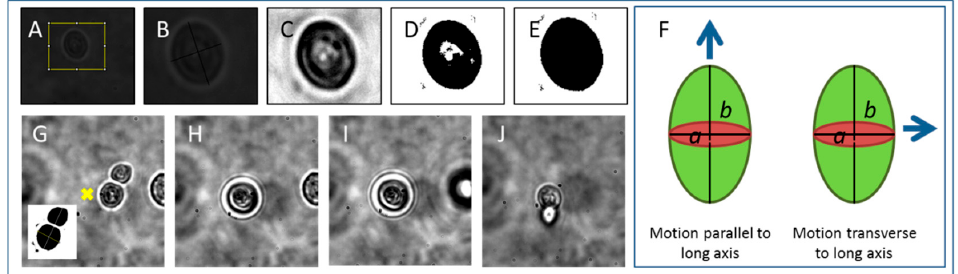
Figure 2. Yeast cell image analysis and tweezing. ( A ) Image of S. cerevisiae cell to be tweezed and its size analyzed; ( B ) zoom in using ImageJ; ( C ) enhanced contrast; ( D ) thresholding applied; ( E ) holes filled in, ‘particle’ to be measured in ImageJ. ( F ) Schematic of how cell is translated in optical tweezers; ( G ) S. cerivisiae with large daughter cell attached. Inset shows how cell dimensions, minor axis a and major axis b are measured in this case; ( H ) cell and attached daughter align in optical tweezer with long axis b , in direction of beam propagation; ( I ) cell and attached daughter are lifted in z using optical tweezers. A nearby cell is seen to move out of focus; ( J ) cell and attached daughter are tweezed at a velocity where they fall out of the trap.